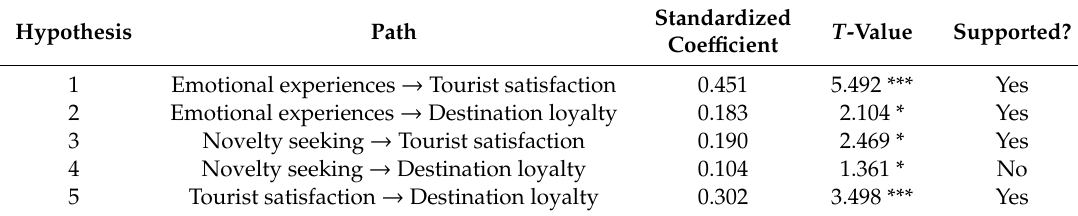
Table 3. Structural parameter estimates.